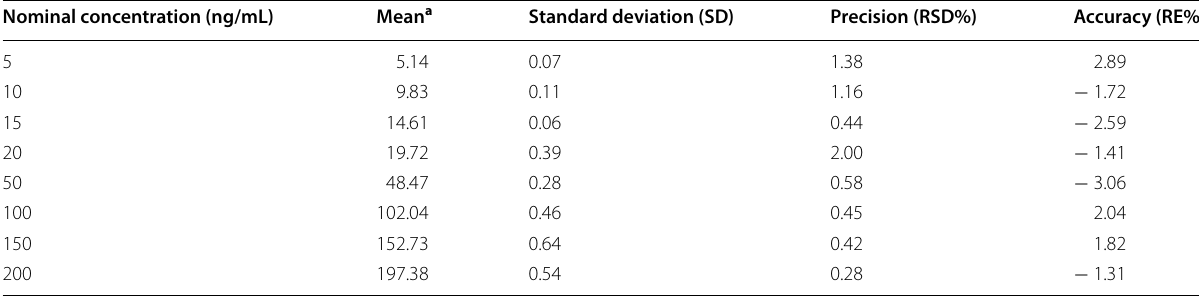
a Average of six determinations